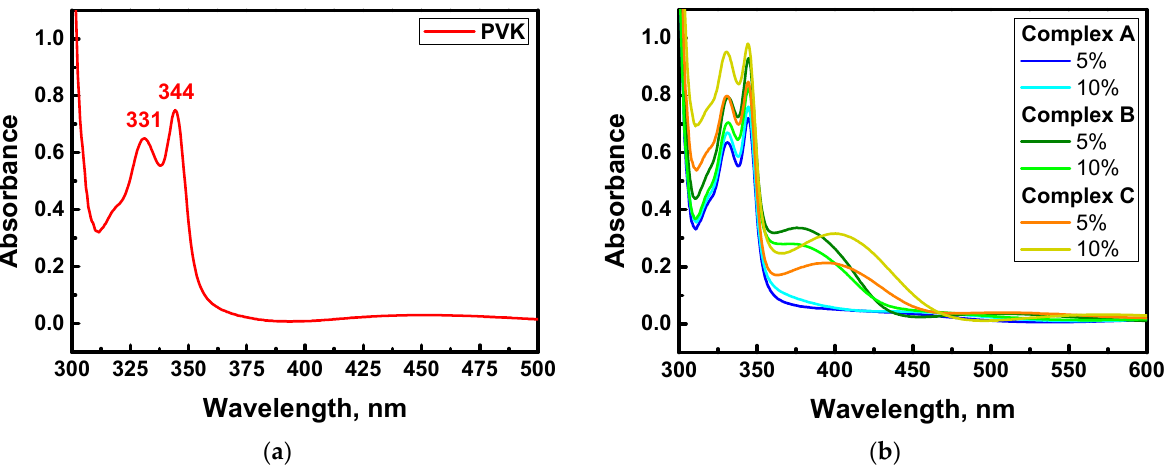
Figure 11. Absorption spectra measured for PVK ( a ) and studied A/PVK-, B/PVK-, and C/PVK- based samples ( b ) in the form of thin films.